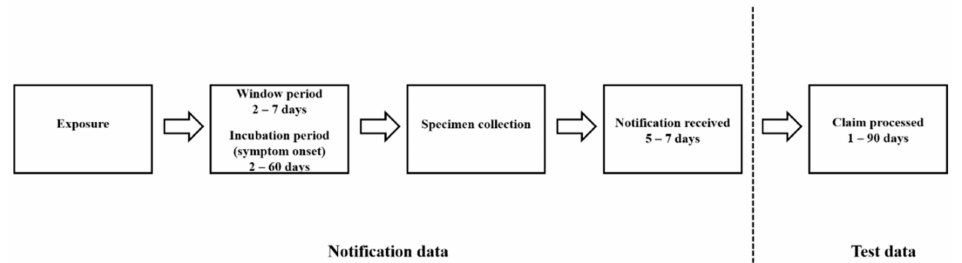
Figure 1. Flowchart from chlamydia exposure to notification (Notification data) and the subsequent financial claim processing of test data (Test data). National Notifiable Diseases Surveillance System defines diagnosis month / year as earliest known of symptom onset date, specimen collection date and notification date. Diagnosis month / year tends to reflect specimen collection or notification date rather than symptom onset date due to the asymptomatic nature of most chlamydia